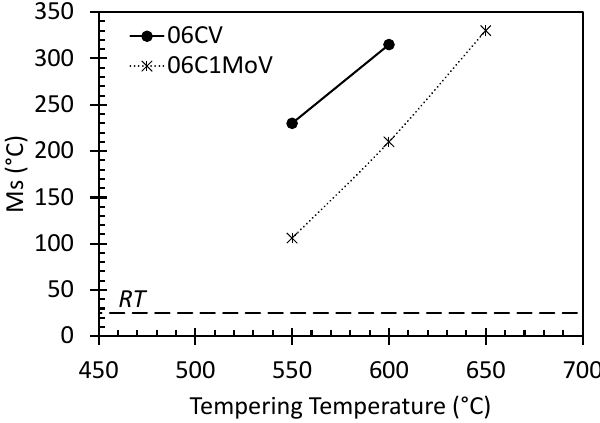
Figure 8. Measured Ms temperatures on cooling after tempering at the indicated temperature.